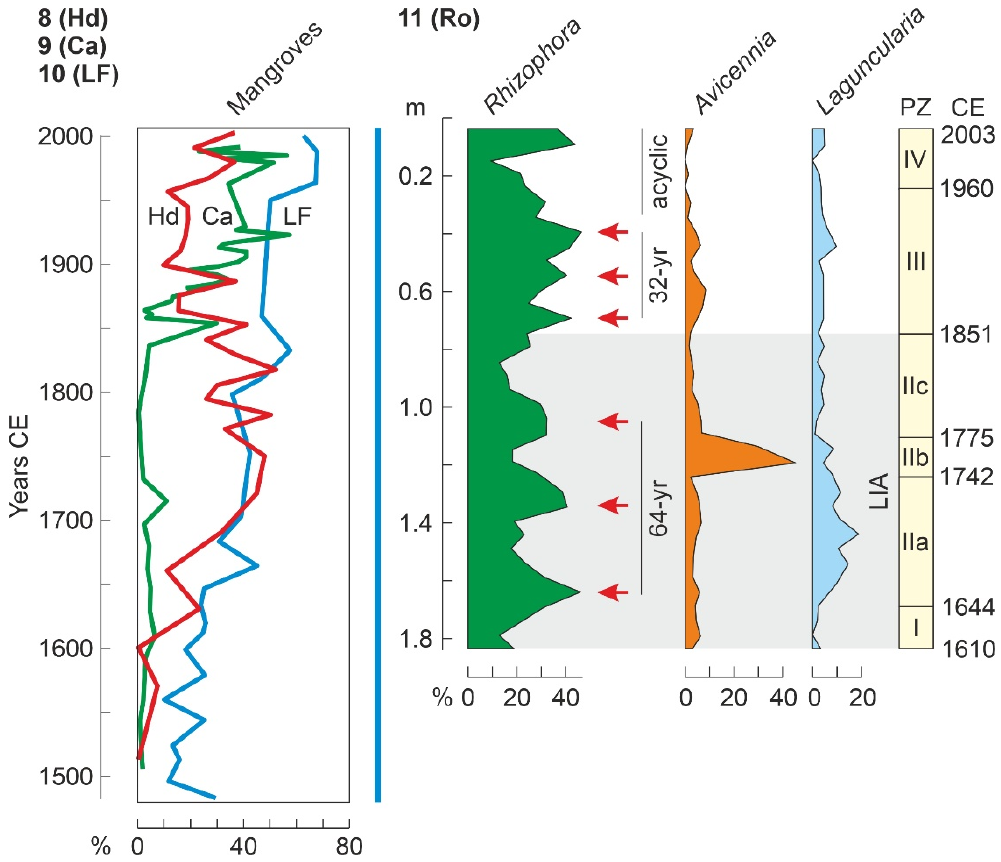
Figure 20. Mangrove dynamics on the Colombian Caribbean coasts during the last five centuries. See Figure 19 for the location of coring sites. PZ, pollen zones. Redrawn from Refs. [149,151,153,155].